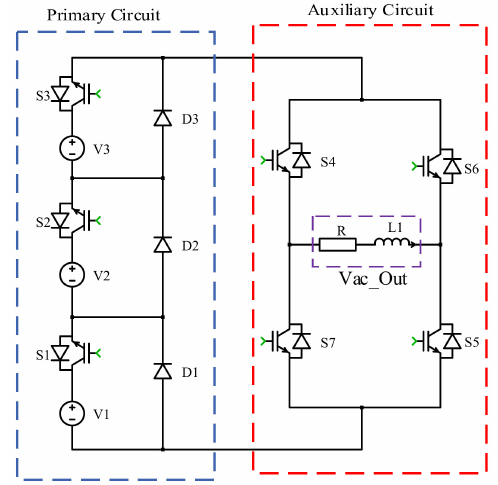
Figure 1. Proposed 15-level asymmetric multilevel